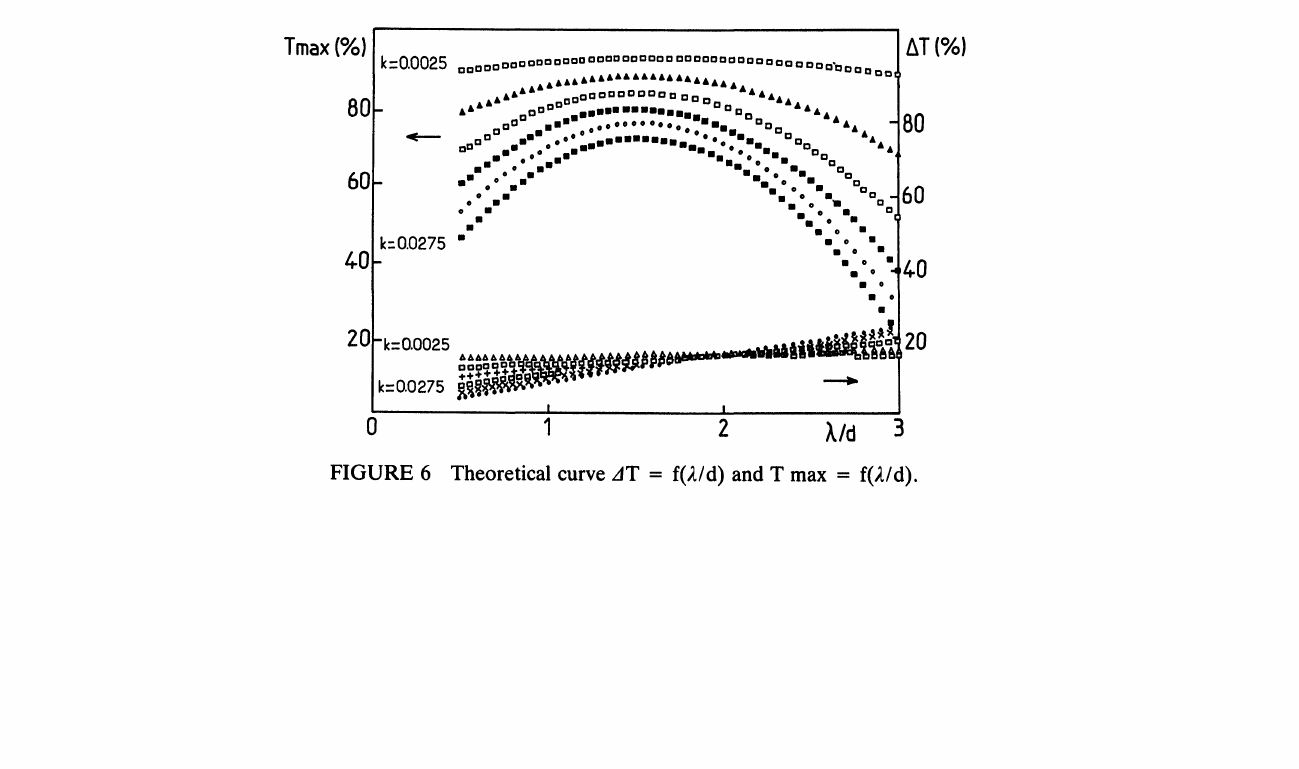
FIGURE 6 Theoretical curve zlT f(2/d) and T max